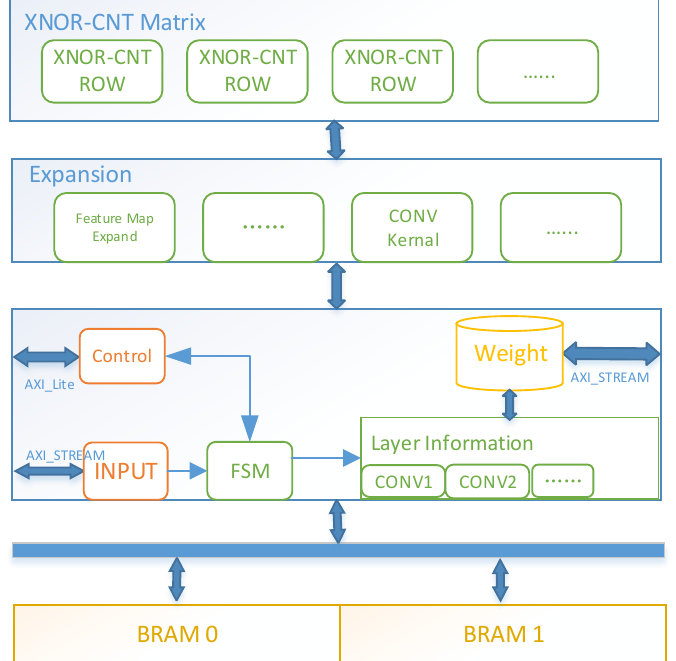
Figure 4. The BNN FPGA accelerator diagram is composed of four blocks: the feature map buffer, a FSM controller, the expansion block, and an XNOR-CNT